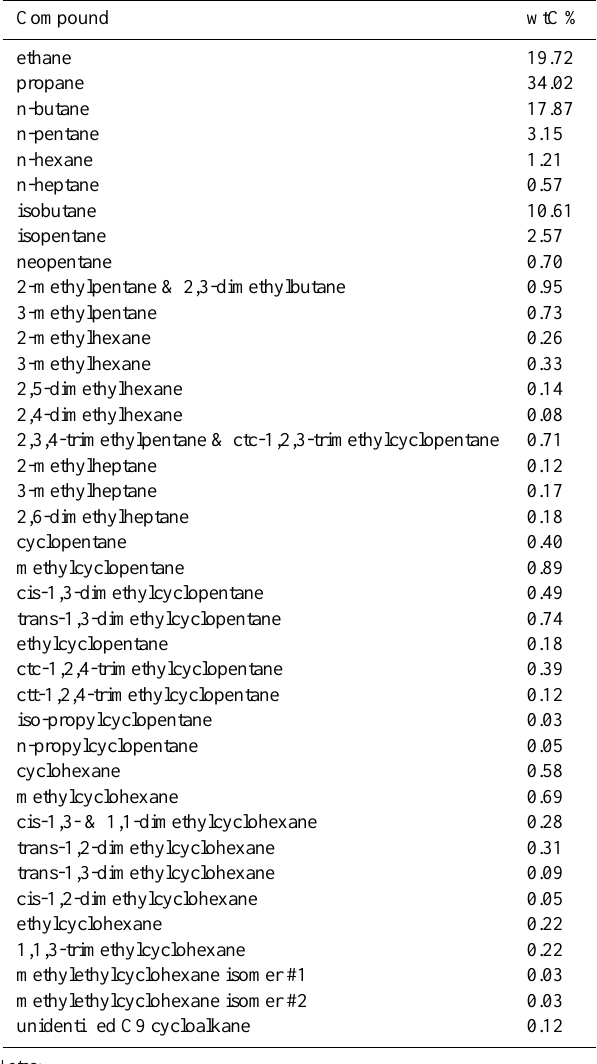
Table 4. Observed petroleum operations source profile at Bakers-